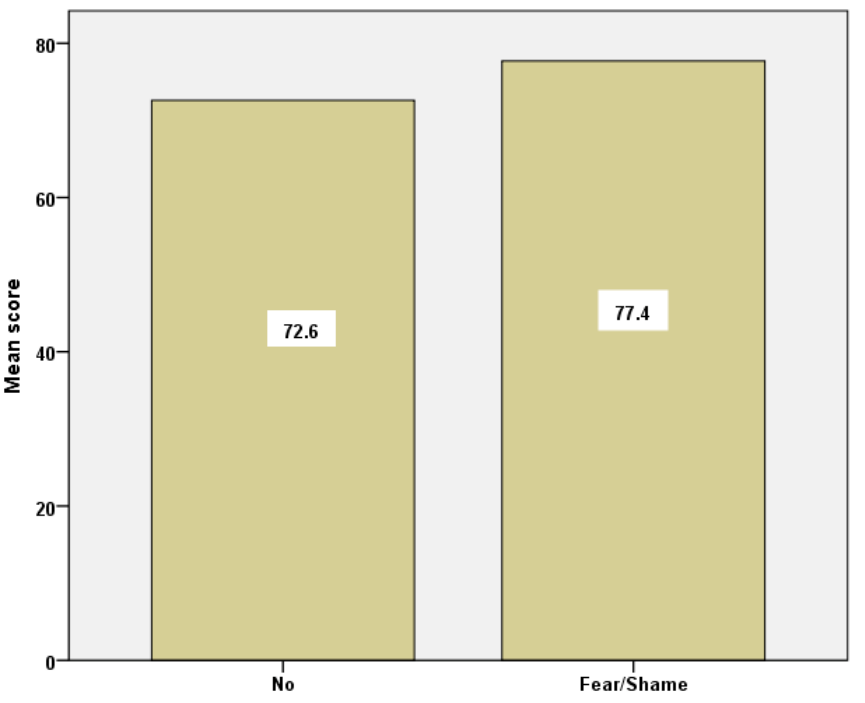
Figure 4. Barchart of social capital mean scores for the group of students who reported ‘fear/shame’ and those who did not.